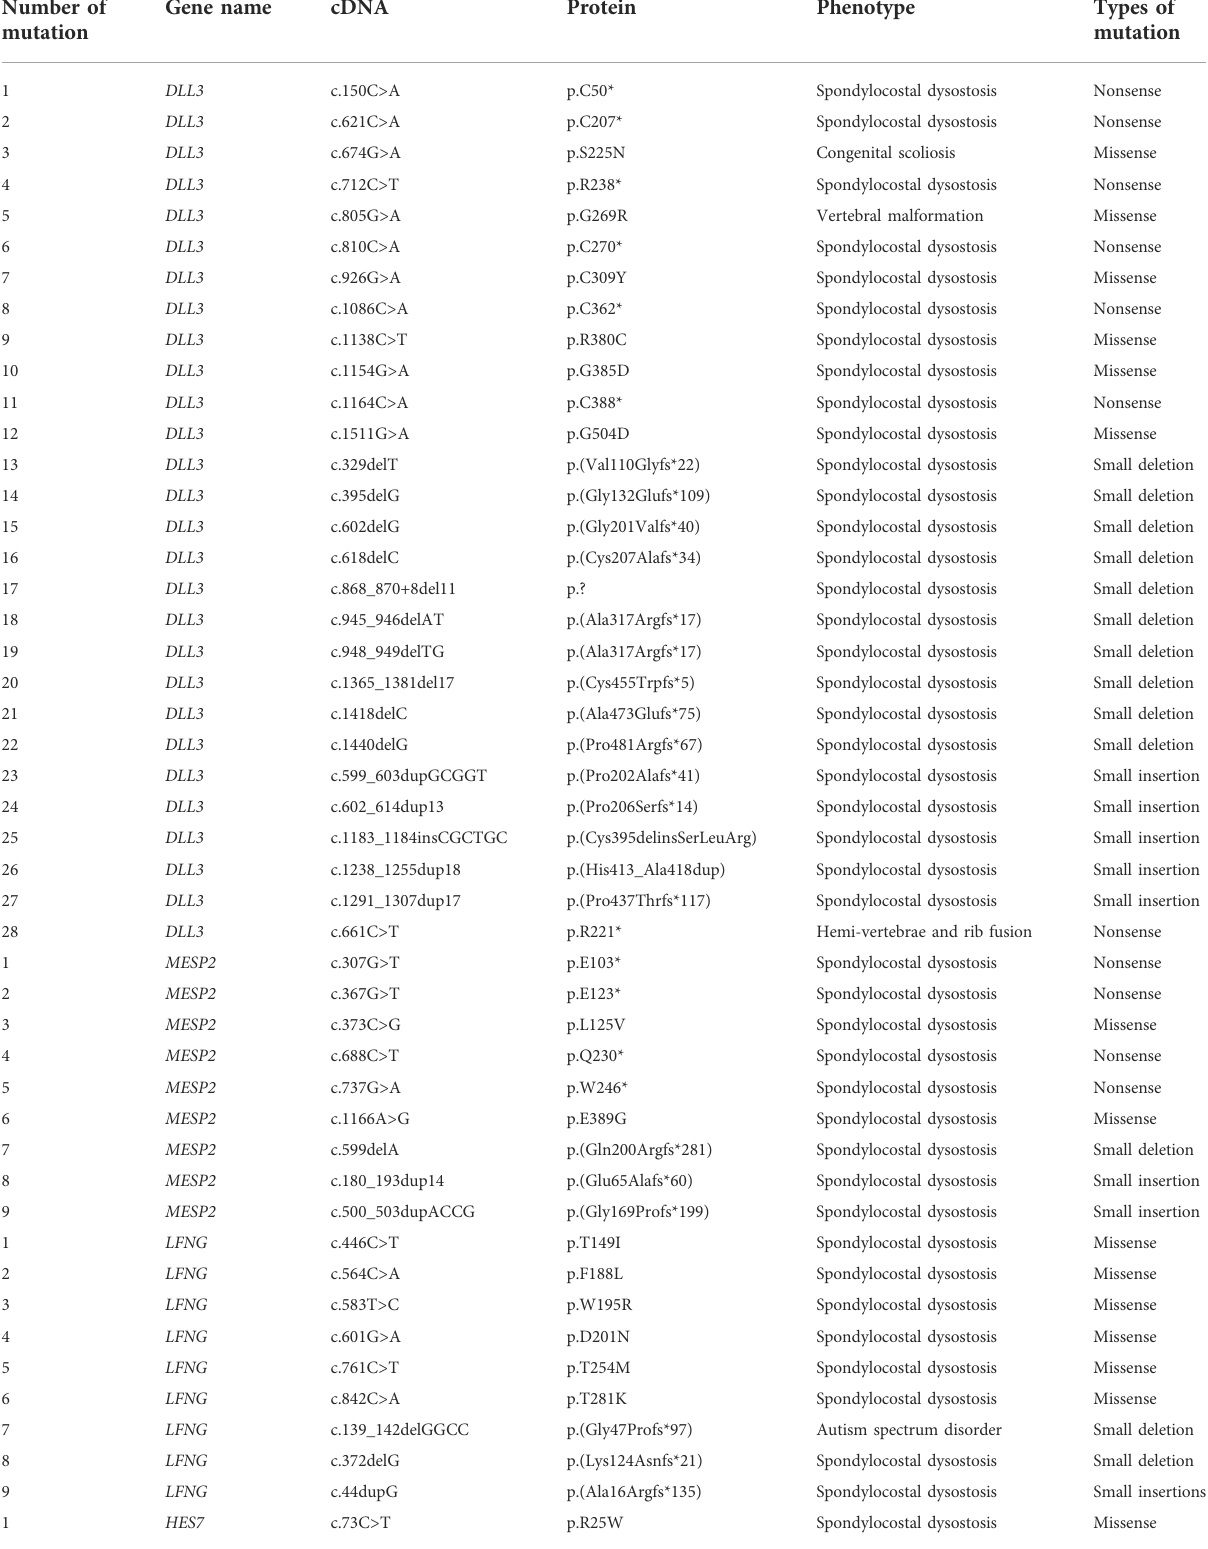
TABLE 2 Mutations reported to date in genes associated with spondylocostal dysostosis (HGMD ® Professional 2022.2). Number of